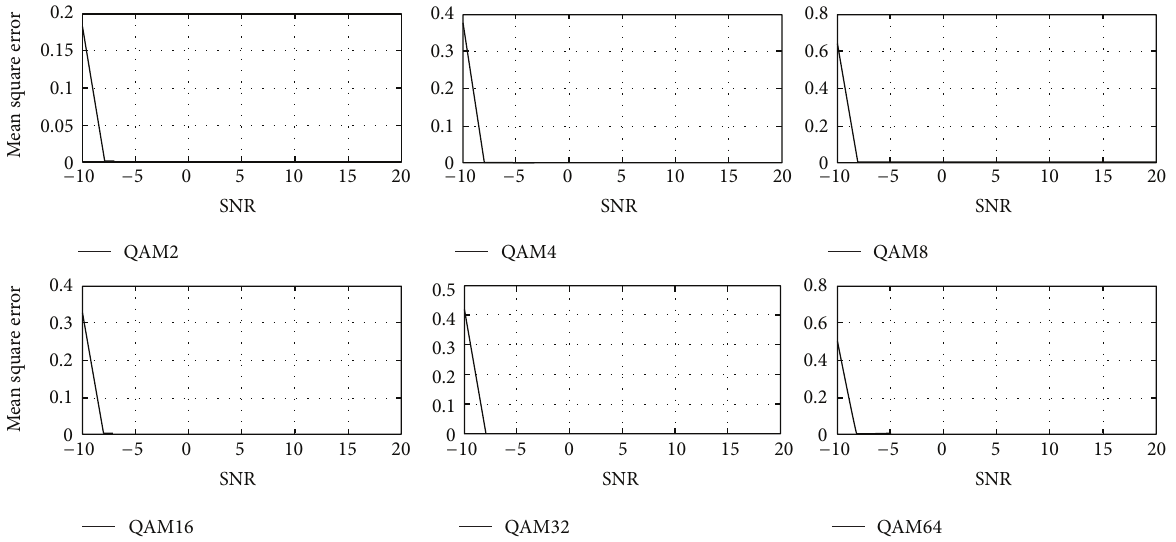
Figure 9: Training of Gabor filter parameters and weights for modulation classification in case of QAM 2–64 at different SNRs and fixed number of iterations.